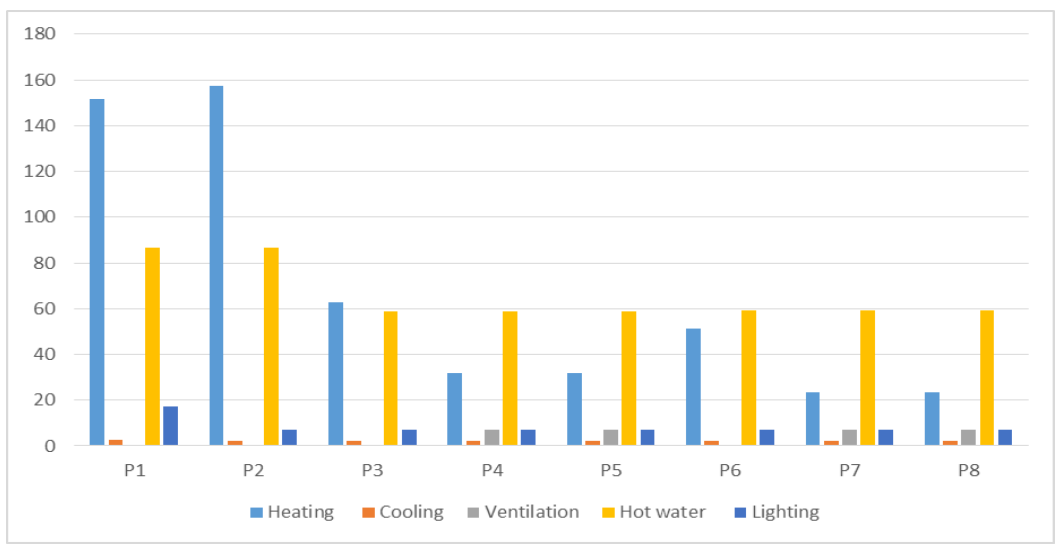
Figure 4. The energy used for heating, cooling, ventilation, hot water, lighting (kWh/m 2 ) as a result of implementing each type of project.